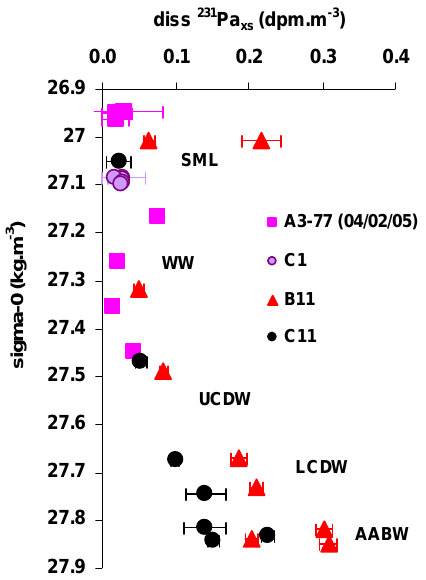
Figure 4 Fig. 4. Distribution of particulate 231 Pa xs / 230 Th xs activity ratios Fig. 5. Distributions of dissolved 231 Paxs concentrations in (2 σ error bars) with depth, on and off the Kerguelen plateau. For Figure 5 dpmm − 3 with sigma-0 density (kgm − 3 ) on and off the Kergue- grey line and bottom depths, see caption of Fig. 3. Note that for len plateau. The main water masses are indicated (SML stands for station C11 the high particulate ratios (2.6 and 2.9) at the surface Surface Mixed Layer; see as well caption of Fig. 1 for the other are not represented in this figure.